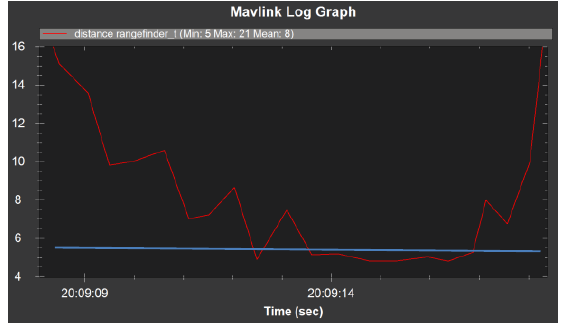
Figure 7. LiDAR distance readings. Retrieved from Mission Planner software